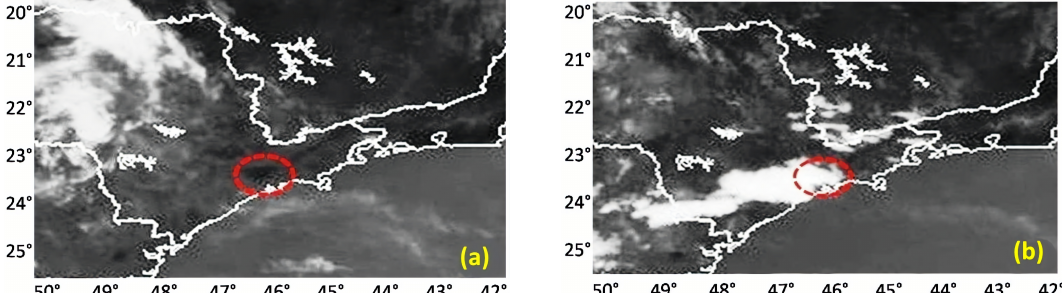
Figure 3. ( a ) Reduced pressure to sea level (hPa) and horizontal velocity fields (m s − 1 ) from the Global Forecast System (GFS) model for 12 January 2015 at 18 UTC (15 LT). The isoline intervals are of 1 hPa. Cold colors indicate lower values and warm colors high values. Patterns of ( b ) convective available potential energy (CAPE) (J kg − 1 ) and ( c ) CIN (J kg − 1 ) are derived from the GFS model for 12 January 2015 at 18 UTC (15 LT). Longitudes, latitudes and geopolitical contours are indicated. The red circle indicates the area around the MASP.